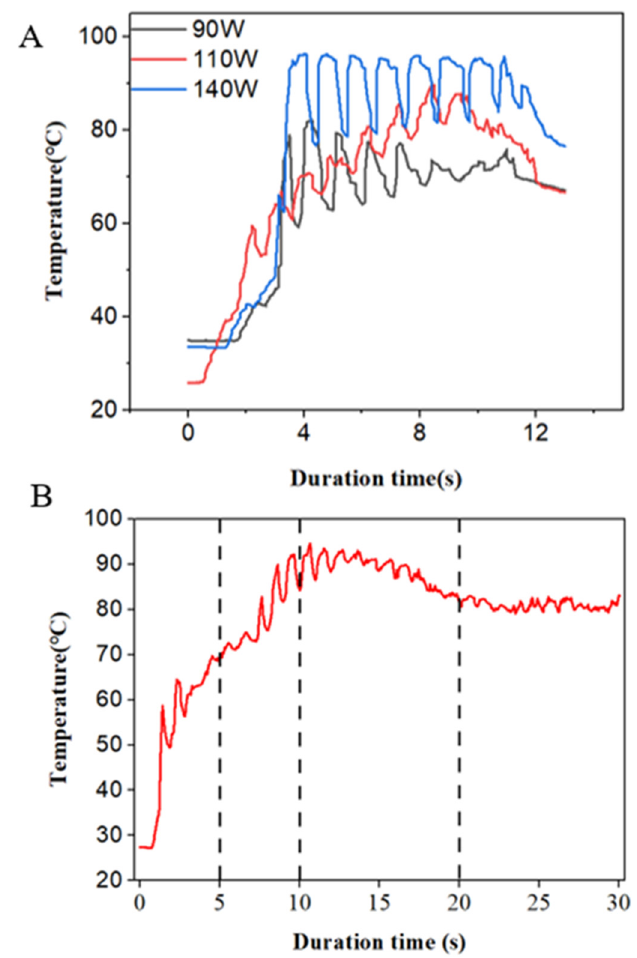
Figure 5. ( A ). Characteristics of tissue temperature at small intestine fusion area under different power. ( B ) Temperature at fusion area changes with time when power is 140 W.